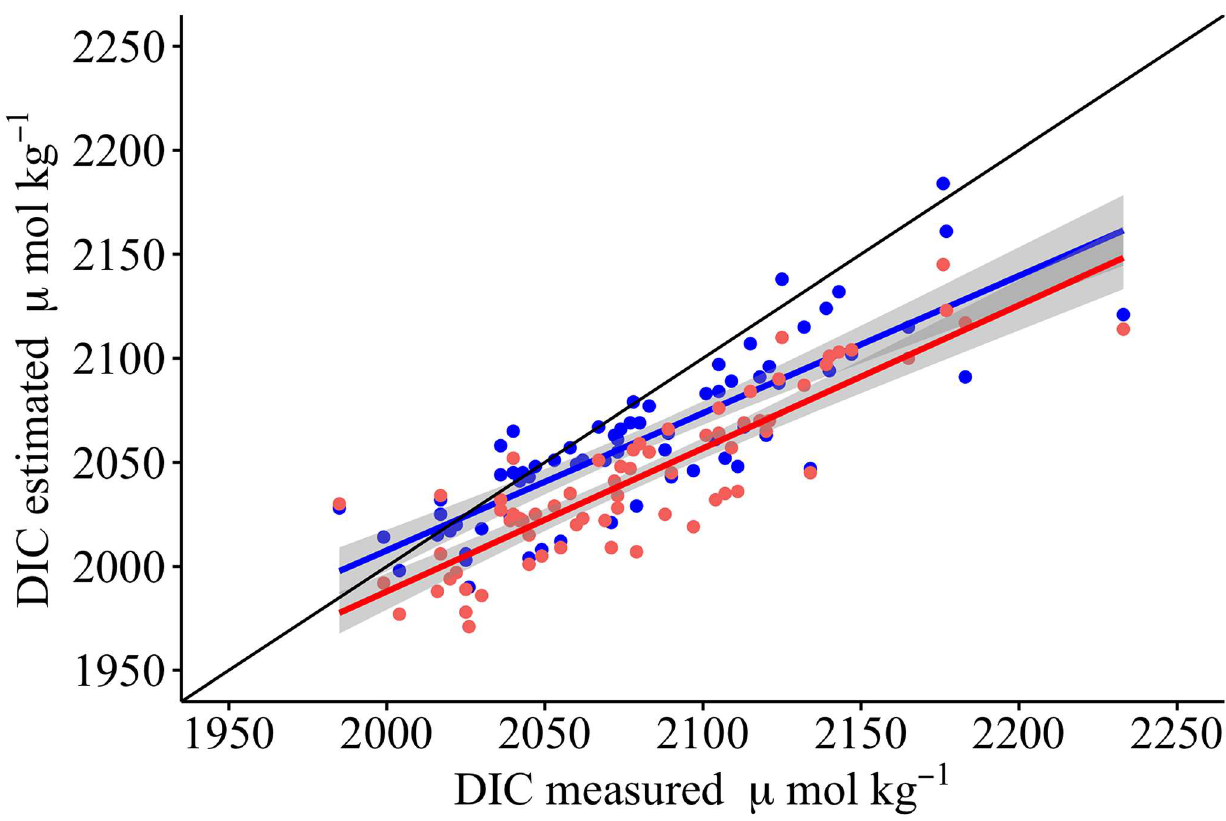
Fig 4. Relationship between measuredand estimated DIC. DIC is estimated either from pH T and TA est (blue points) or pH T and regional averageTA (red points). The black line denotesthe theoretical 1:1 relationship,the blue and red lines the respectivecorrelations with the grey shadingmarkingthe 95% intervals. See text for